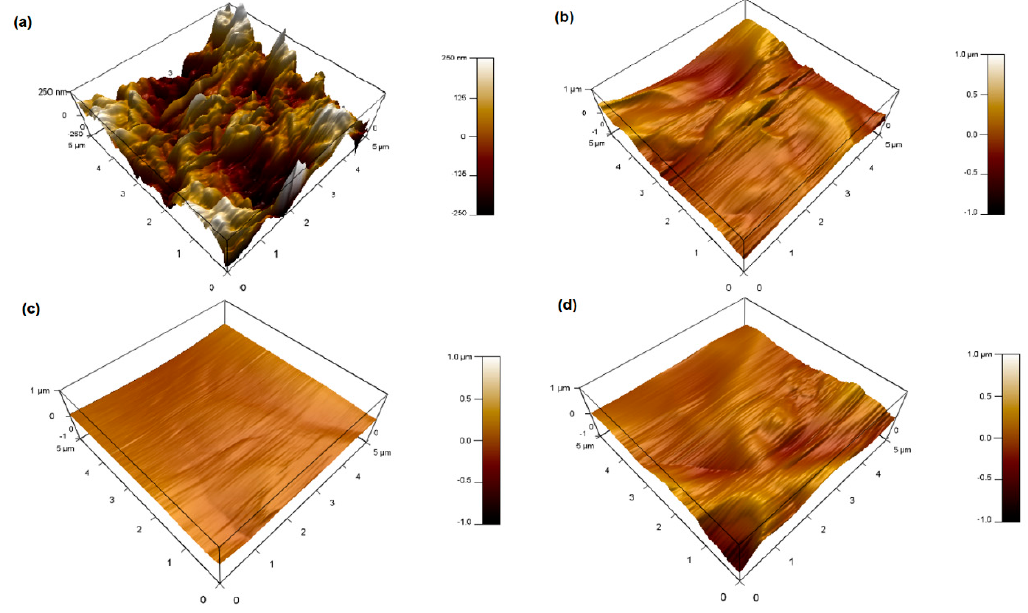
Figure 11. PFM Amplitude retrace of PVDF/TPU (1:3) at different applied voltages. ( a ) 1 V, ( b ) 5 V, and ( c ) 10 V.